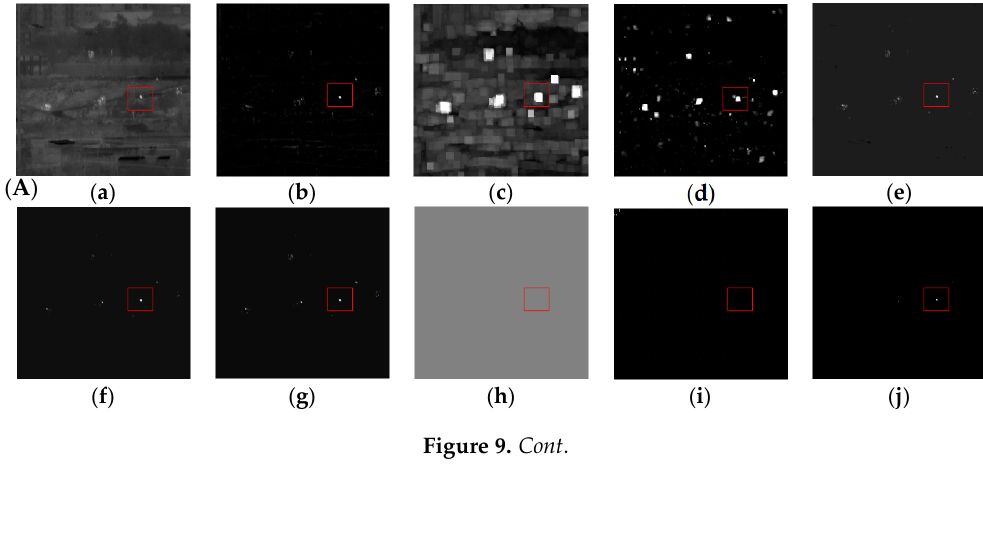
Figure 8. Results of different approaches to Scenes 3 and 4. ( A ) Scene 3 (Sequence 3); ( B ) Scene 4